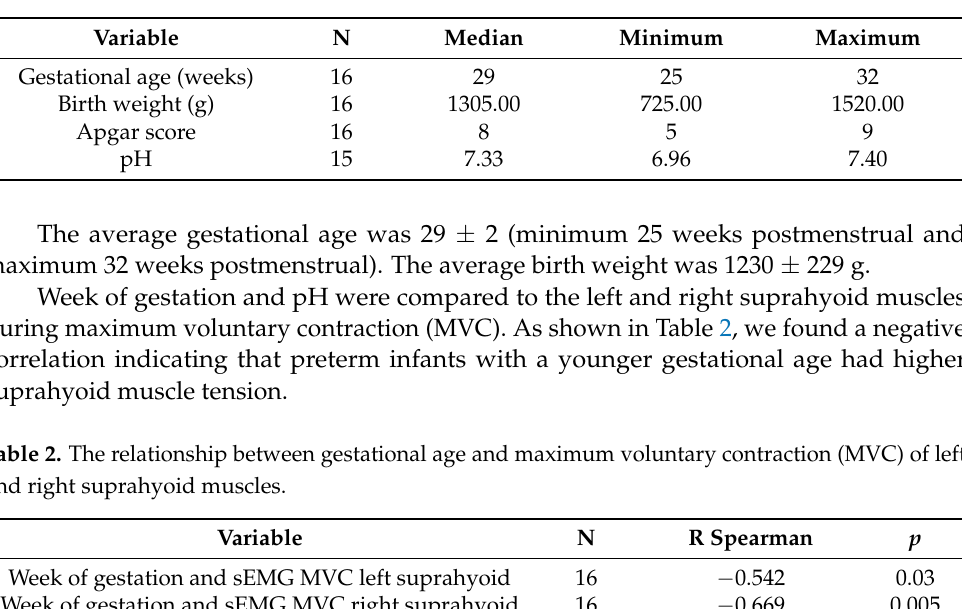
Table 1. Descriptive statistics of test subjects, with neonates’ gestational age, birth weight, Apgar score, and blood pH at the time of birth.